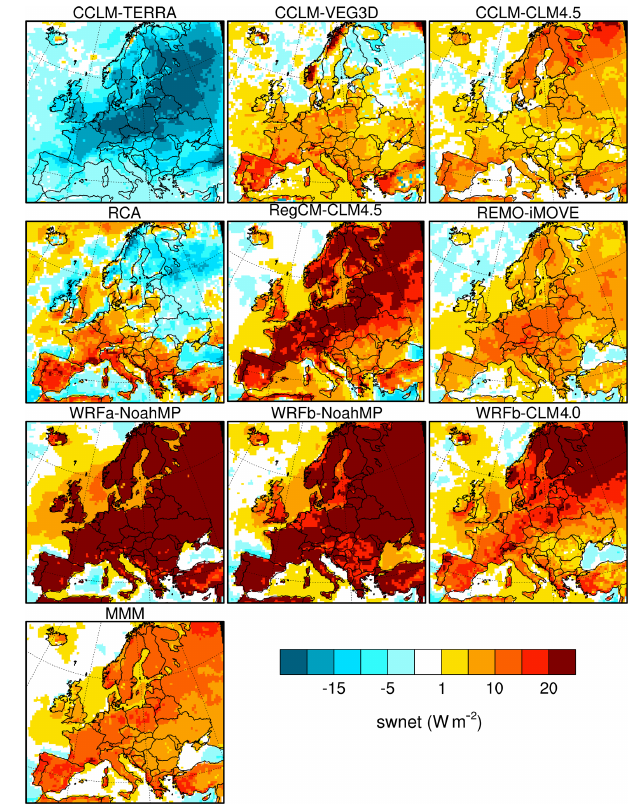
Figure 8. Seasonally averaged net surface shortwave radiation (FOREST minus GRASS) for summer